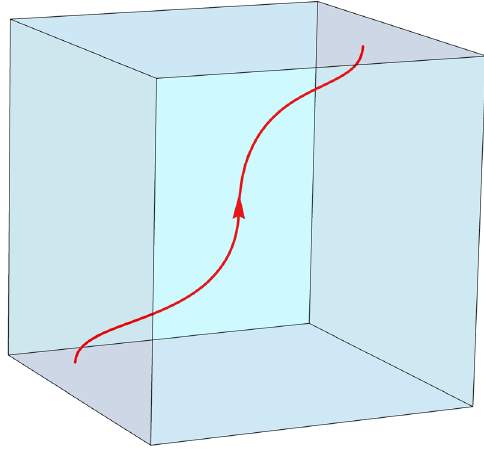
Fig. 2 Harmonic fi elds. Illustration of a harmonic polarisation fi eld line (red) in a simply connected system: the fi eld line starts and ends on the system boundaries, with no divergence or curl within the volume of